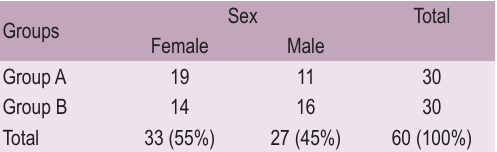
TABLE 2. Gender characteristics of the sample Groups